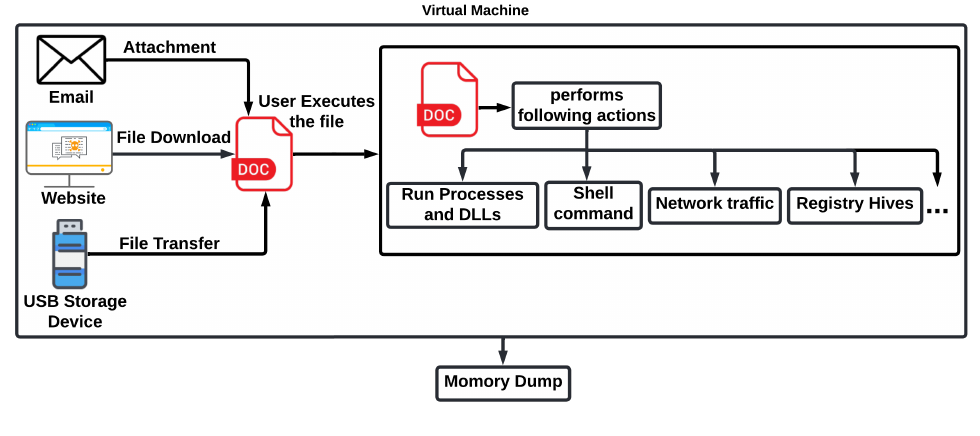
Figure 7. Virtual machine insights. Table 3. Detail of Virtualized